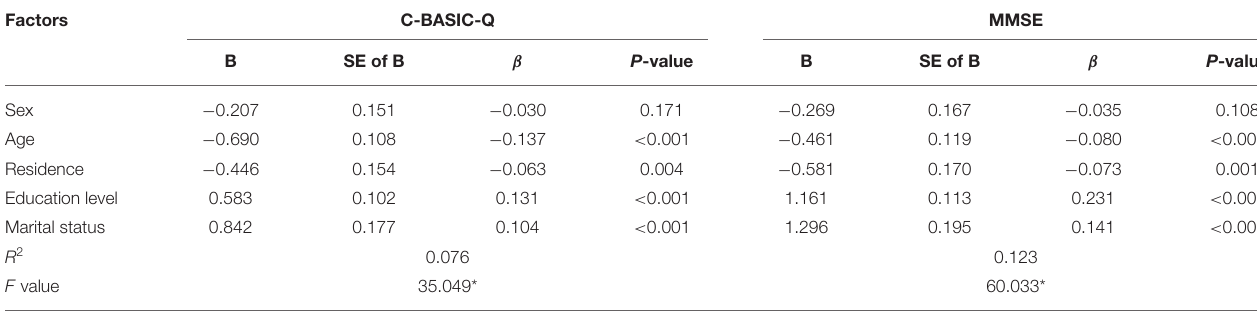
TABLE 7 | Linear regression analysis for the contributions of sex, age, residence, education level, and marital status on C-BASIC-Q and MMSE.